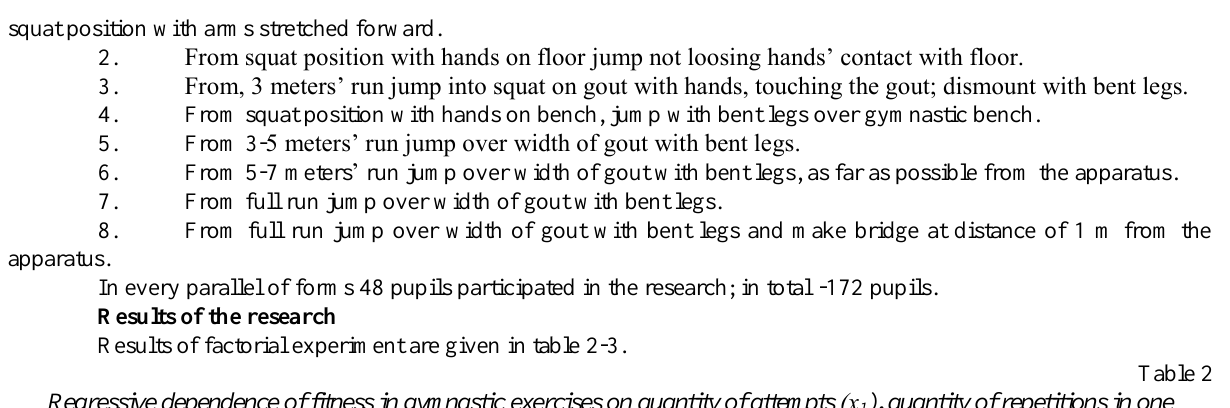
Regressive dependence of fitness in gymnastic exercises on quantity of attempts (х 1 ), quantity of repetitions in one attempt (х 2 ) and rest intervals (х 3 ) of 1-4 form pupils Regression equation for coded Form Description of exercises